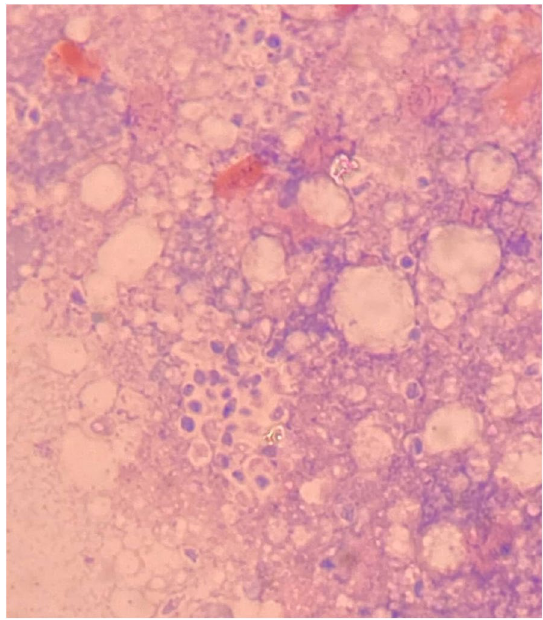
Fig. 4 Wright stain of biopsy-tissue of the leg showing intracellular and extracellular